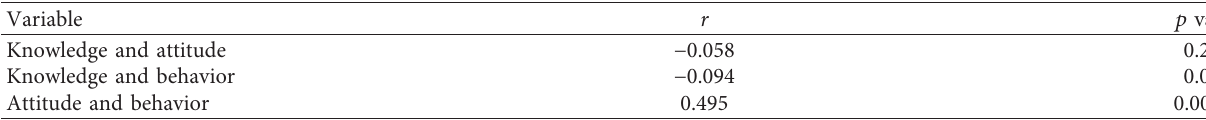
Table 5: Relationship between knowledge, attitude, and